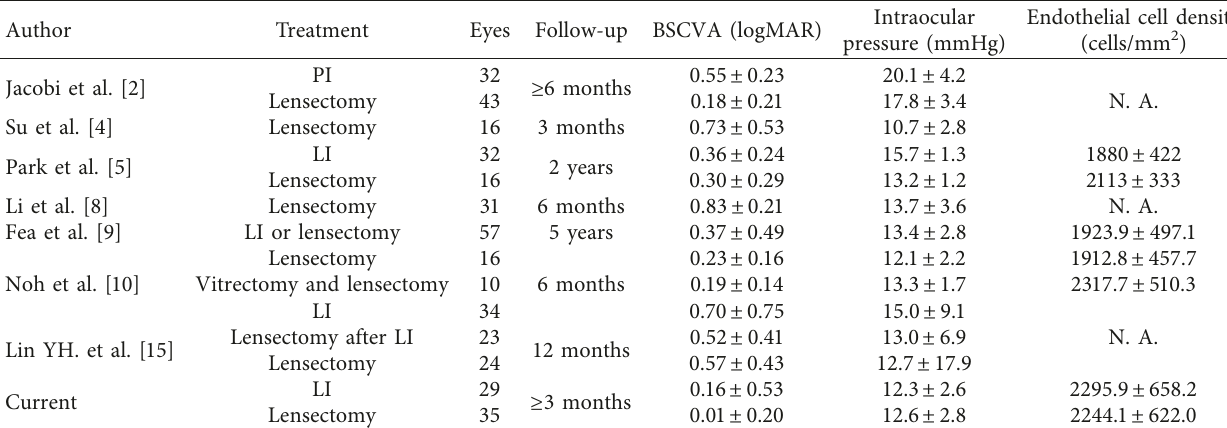
Table 4: Summary of previous studies on the treatment outcomes of acute primary angle